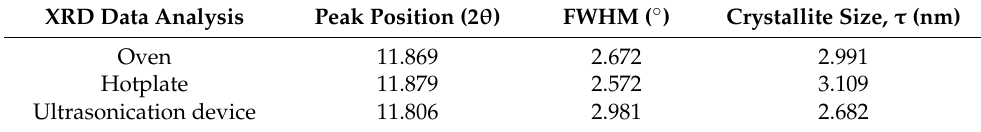
Table 2. FWHM and crystallite size of the PDMS thin films under different curing methods. XRD Data